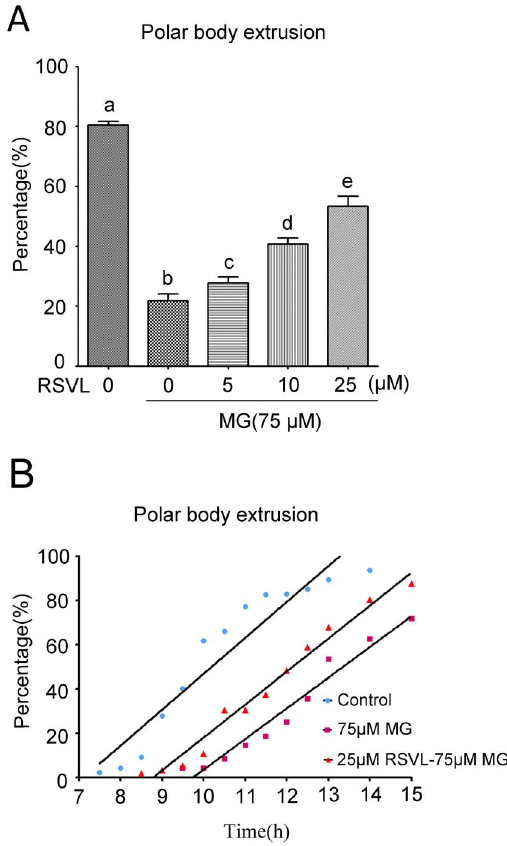
Figure 2. Effect of MG and resveratrol on meiotic maturation of mouse oocytes. ( A ) Percentage of first polar body (PB) extrusion in 75 m M MG and different concentrations of resveratrol group. Different letters denote statistical difference at a P , 0.05 level of significance. ( B ) Kinetics of PB1 extrusion of control group, 75 m M MG-treated group and 25 m M RSVL-MG-treated